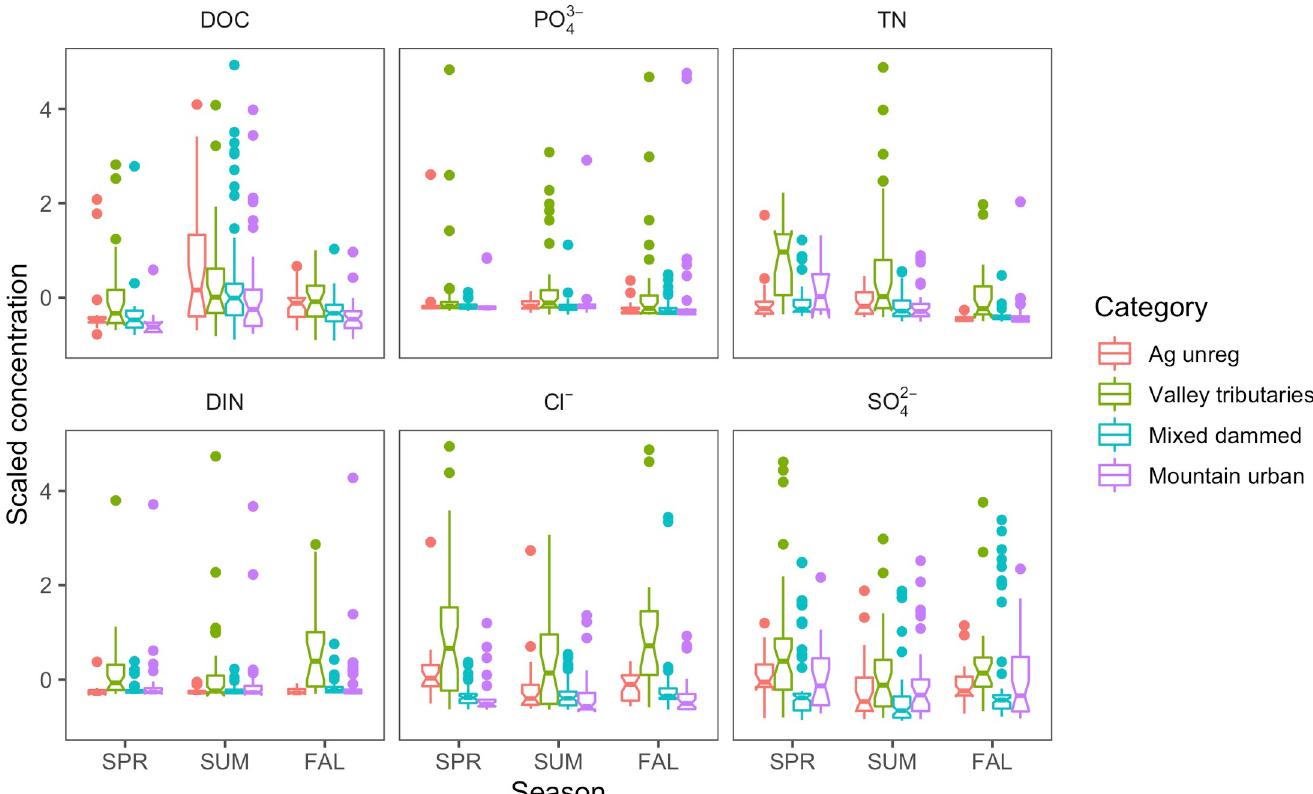
Fig 2. Scaled concentration of solutes in Utah Lake subwatersheds. Samples were collected during synoptic sampling events in three seasons (SPR = Spring, SUM = Summer, FAL = Fall) in watersheds with different land use categories (Agricultural unregulated, Mixed dammed, Mountain urban, and Valley tributaries). Boxplots represent the 25 th , 50 th , and 75 th percentiles, points within 1.5 times the interquartile range, and points beyond. The notches represent the 95% confidence interval of the median (non-overlapping notches suggest statistically significant differences between populations).